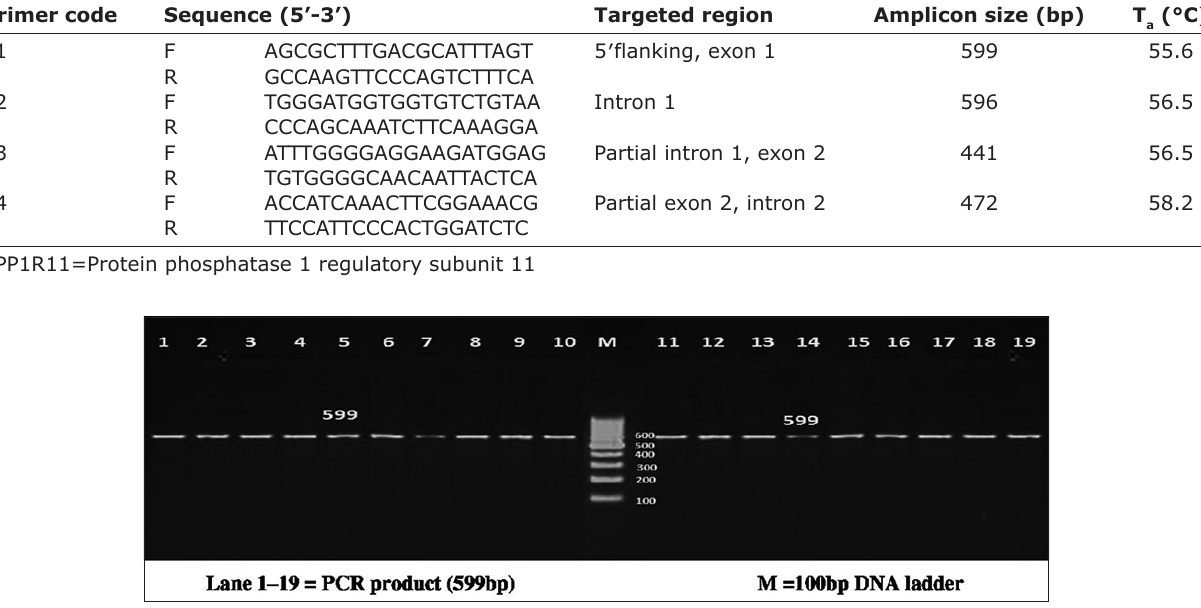
Figure-1: Resolution of polymerase chain reaction (PCR) amplified product of Primer 1 on 2% agarose gel. Lane 1-19=PCR product (599 bp), M=100 bp DNA ladder.